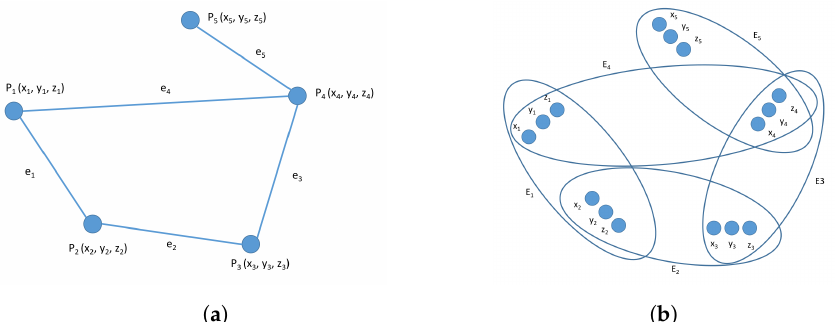
Figure 2. Graph and hypergraph structure for a mesh in 3D space. ( a ) Graph structure. ( b ) Hyper- graph